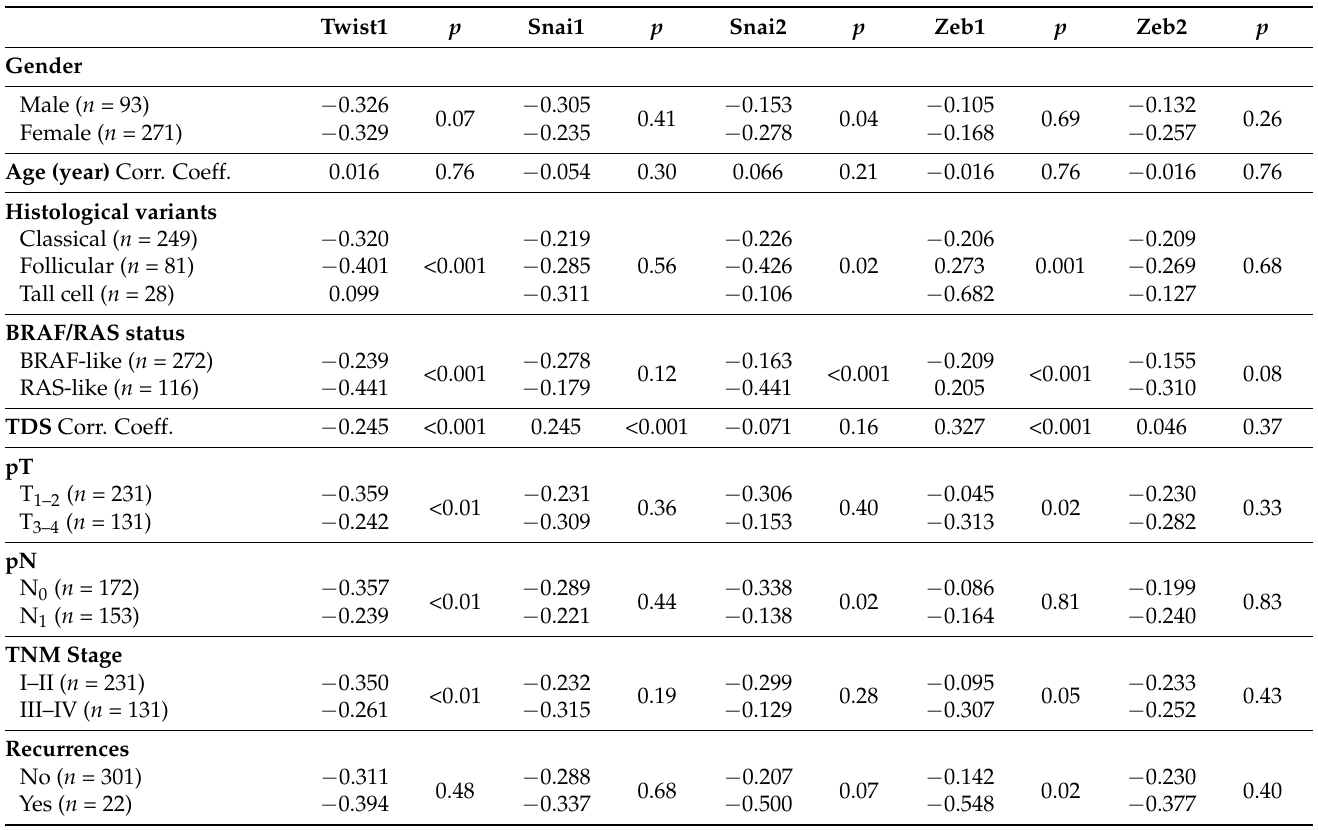
Table 4. Univariate analysis of the EMT-TF expressions and clinicopathological features of over 350 PTC patients from the TGCA database. In parentheses is the number of patients. TDS, Thyroid Differentiation Score. Median values of the mRNA Z-scores in PTC tissues are listed for each category of clinical parameters, except the patient’s age and TDS, for which correlation coefficients are